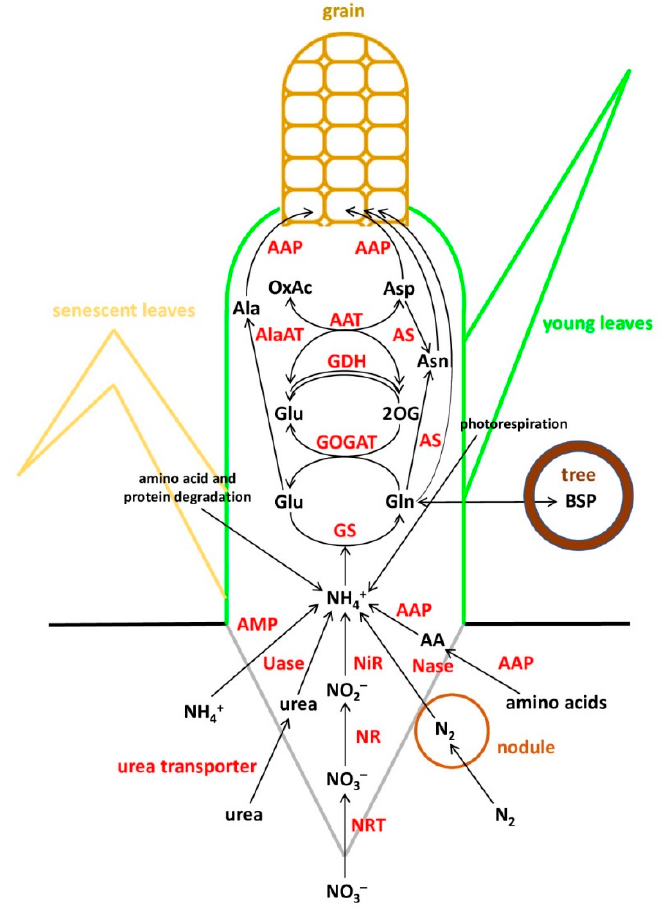
Figure 1. Schematic representation of nitrogen metabolism in plants.